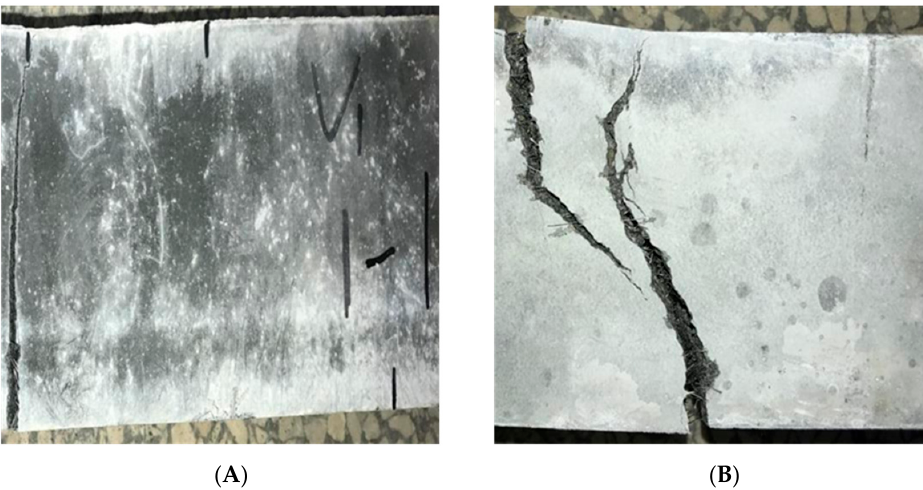
Figure 4. Different concrete images. ( A ) Micro crack image; ( B ) biggest crack image.